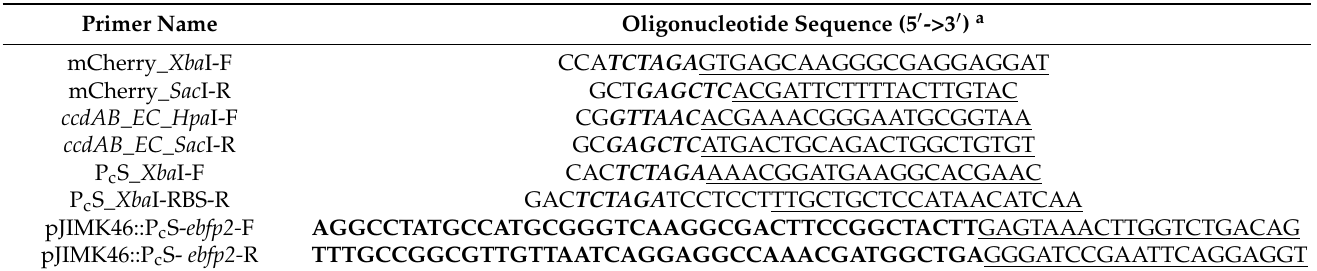
Table 3. Oligonucleotide primers used in this study.